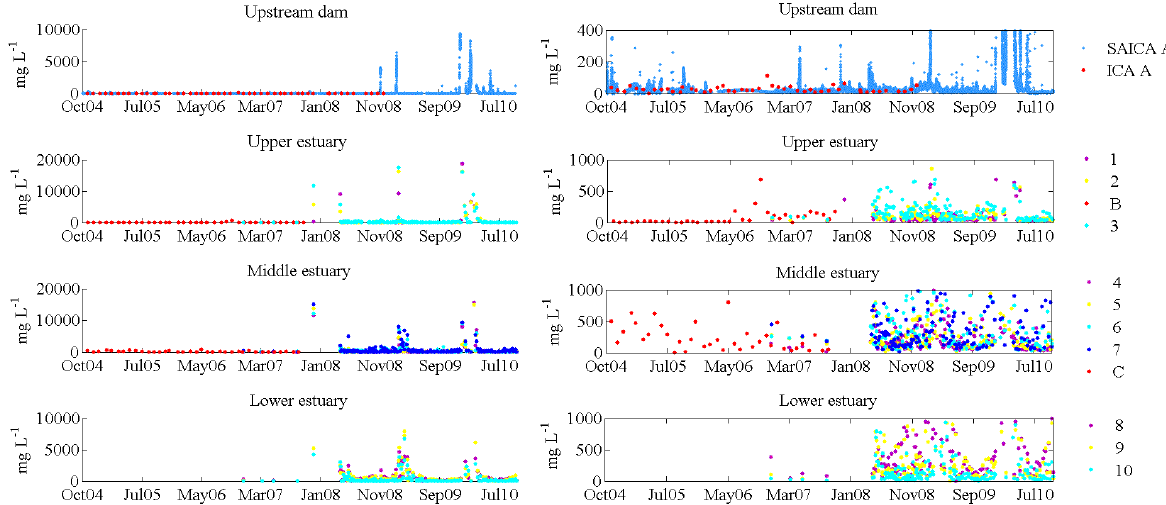
Fig. 3. SSC in ICA, JA and SAICA stations throughout the estuary, period October 2004–July 2010 (left), and showing values below 400mgL − 1 upstream of the dam and below 1000mgL − 1 in the estuary